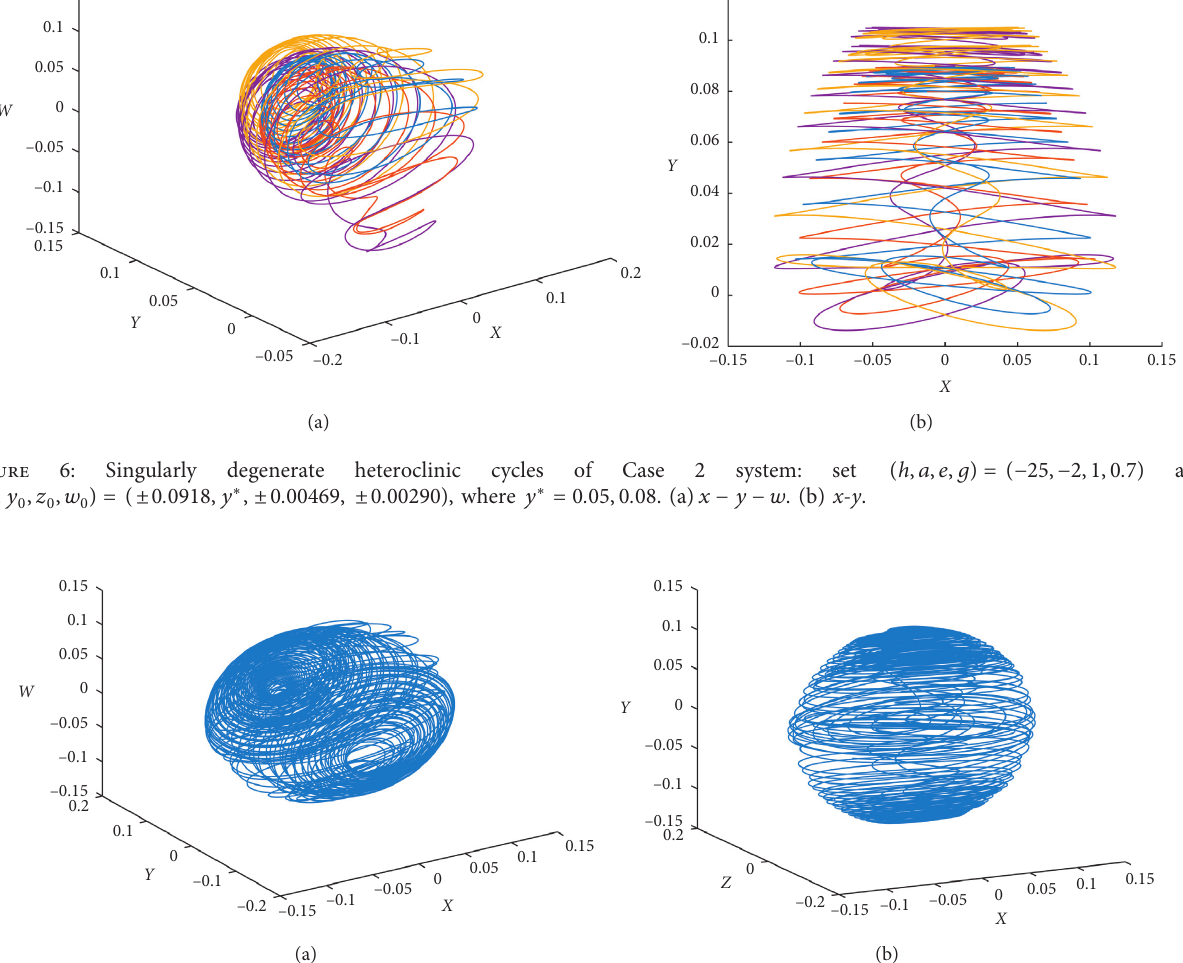
, y ,z , w ) � ( 1 , 1 , 1 , 1 ) . (a) x - y 0 0 0 0